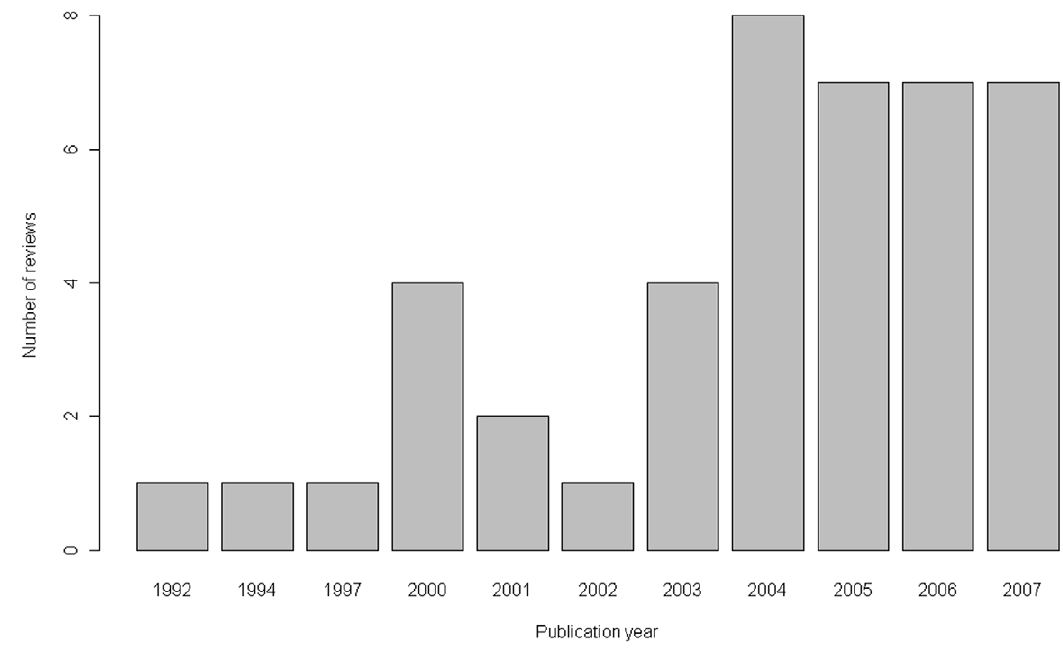
Figure 2. Frequency of published reviews including indirect comparisons, by year of publication.